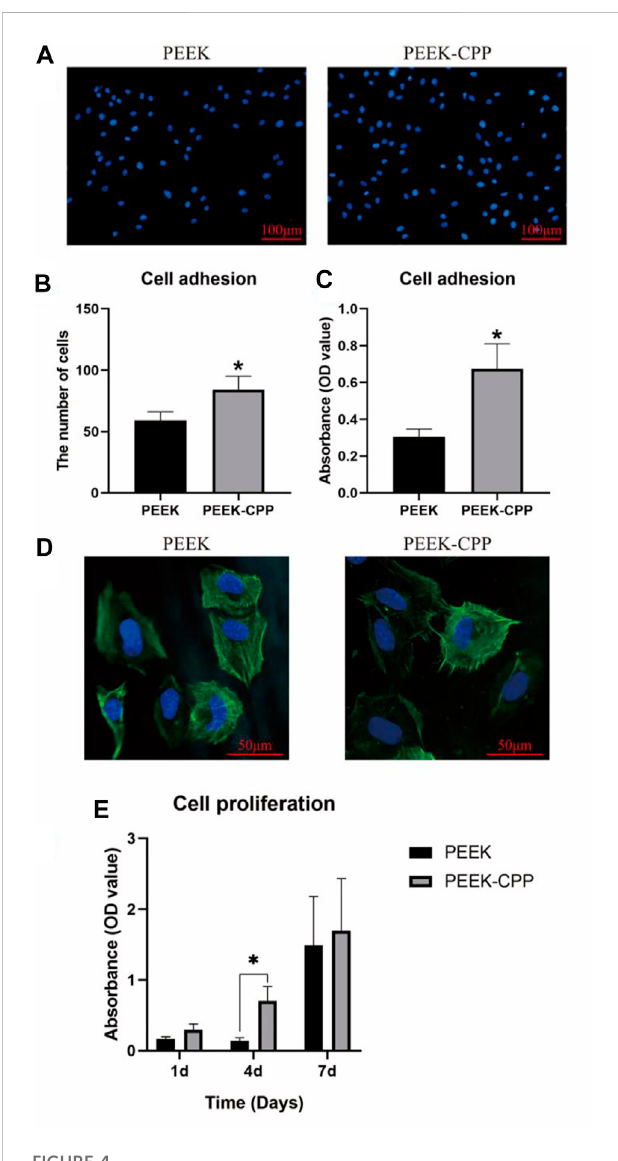
Cell adhesion and proliferation on different PEEK specimens. (A, B) Representative images of cell adhesion and cell count by DAPI staining ( n = 5). (C) Cell adhesion testedbyCCK-8assay ( n =3). (D) Cell adhesion morphology by CLSM observation. (E) Cell proliferation tested by CCK-8 assay ( n = 3). * The asterisk indicates statistically signi fi cant differences between groups ( p <